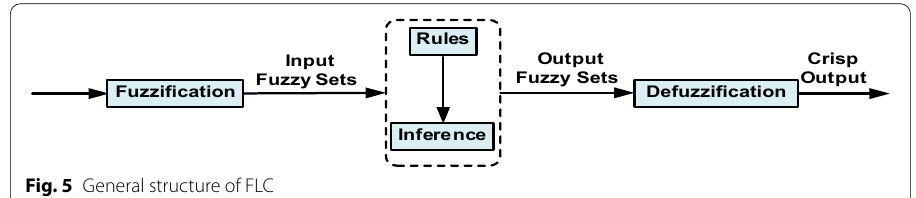
Fig. 5 General structure of